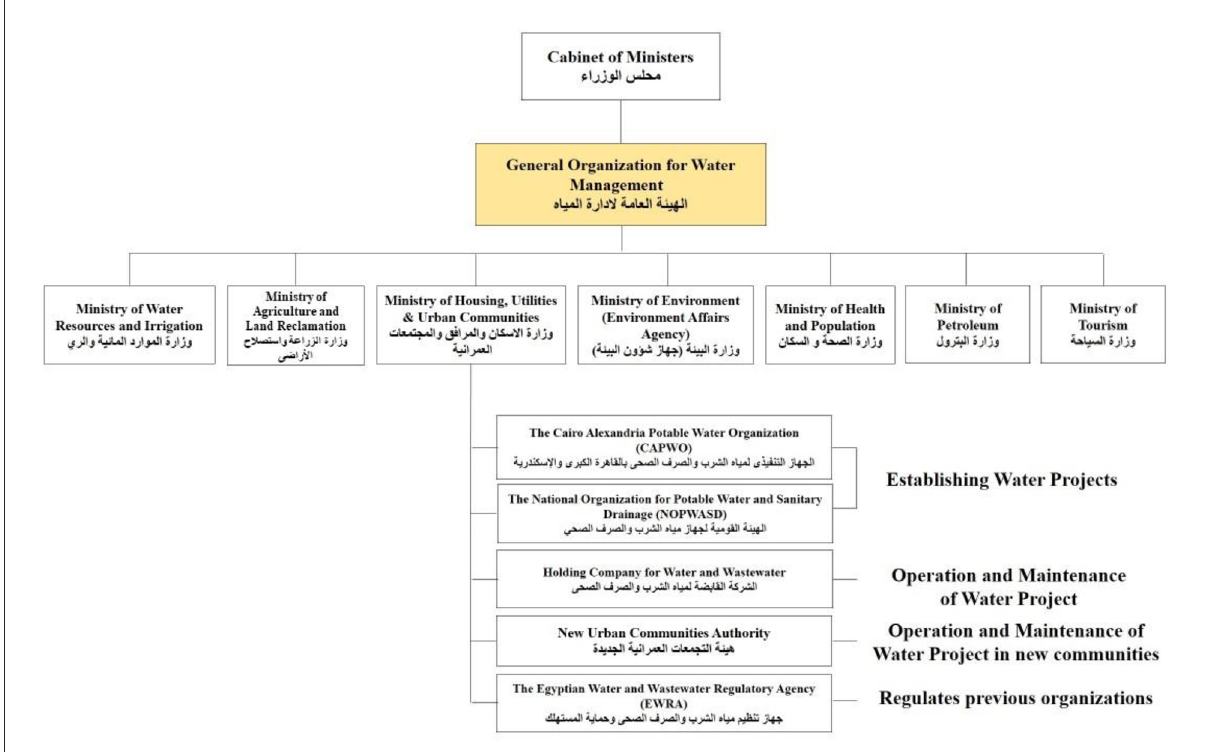
FIGURE6 Final suggested organization chart for key stakeholders in the water sector after the feedback from the interviews. The general organization for water management was added to ensure cooperation between all